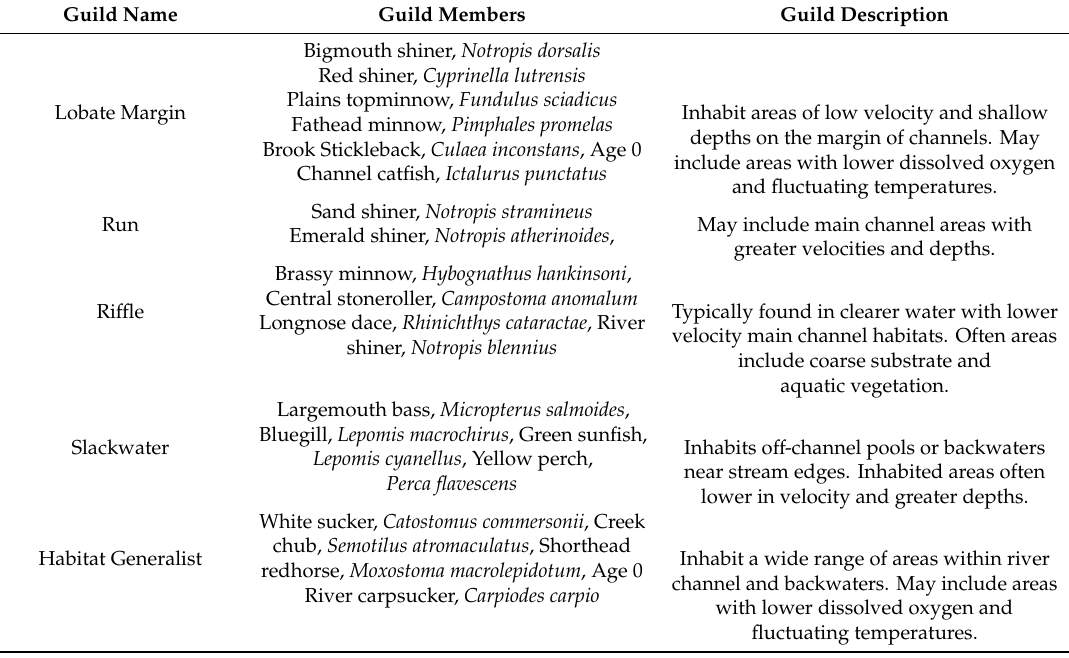
Table 1. Description of fish guilds determined for the Niobrara River using empirical fish species data collected within hydromorphologic units using prepositioned area electrofishing. Detail of guild formation is available in Pegg et al.